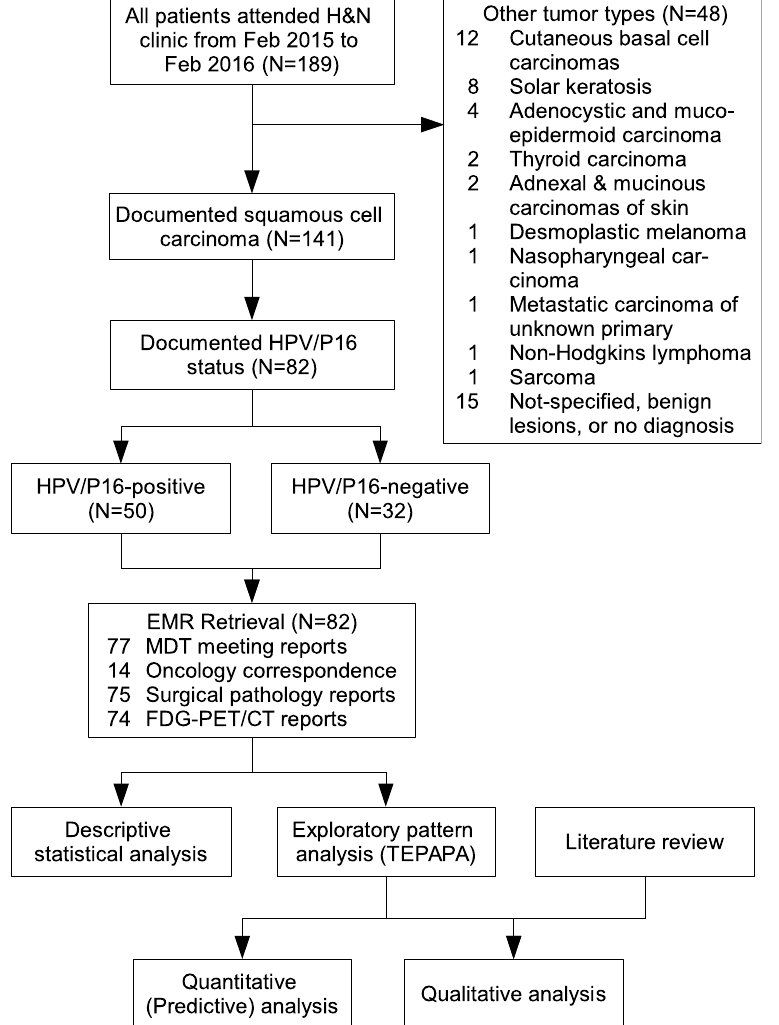
Figure 3. Flowchart of data analysis of the validation